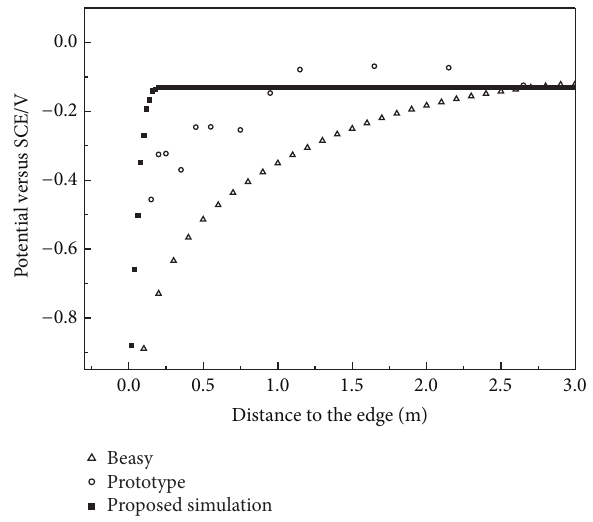
Figure 4: Plot of potential versus distance to the prototype tube edge: proposed and Beasy-GID